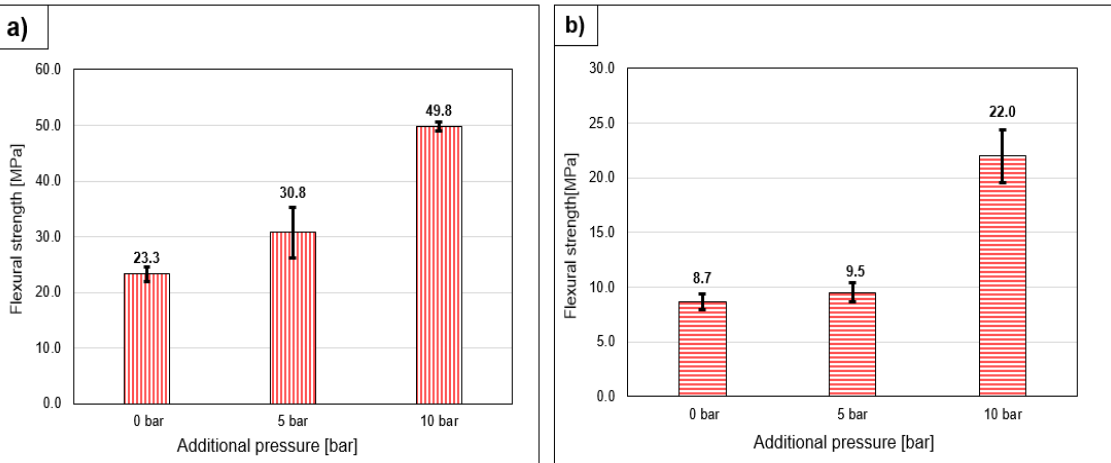
Figure 7. Flexural strength comparison of samples printed in different pressure conditions ( a ) lon- gitudinal and ( b ) transverse to the printing direction.